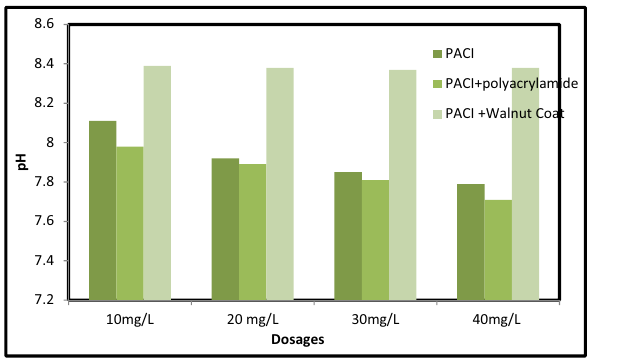
Figure 9: The relation between pH and dosages of coagulant and its aids for samples at 120 cm height.